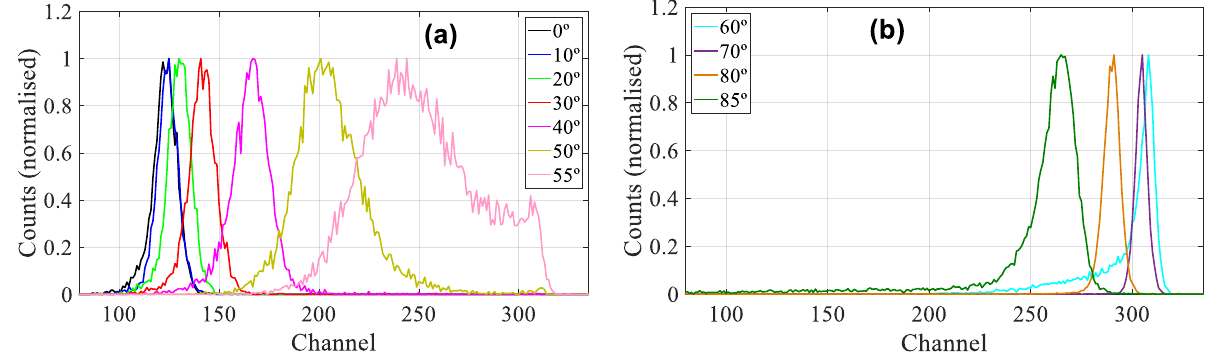
Figure 8. IBIC spectra from PIN diode in counts vs channel. ( a ): measurements up to 55° from which the thickness of the active layer is obtained. ( b ): the spectra for 60°, 70°, 80° and 85° from which the thickness of the dead layers (Al equivalent) is extracted.